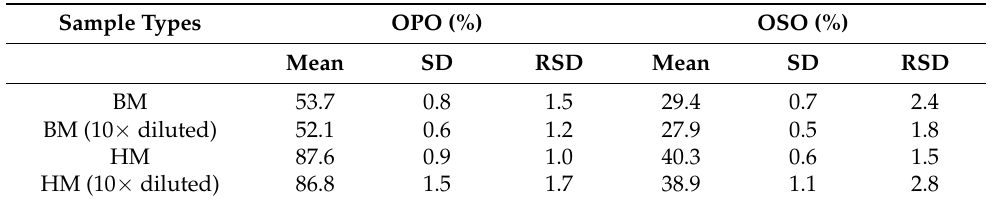
Table 1. Method repeatability ( n = 3).